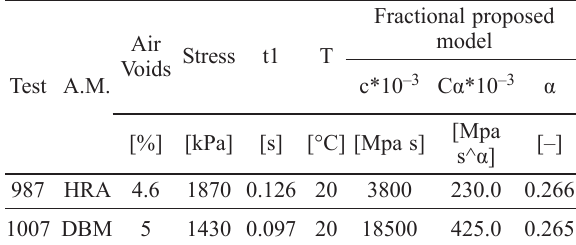
Table 1. Best fitting parameters of creep tests 987 (HRA) and 1007 (DBM)